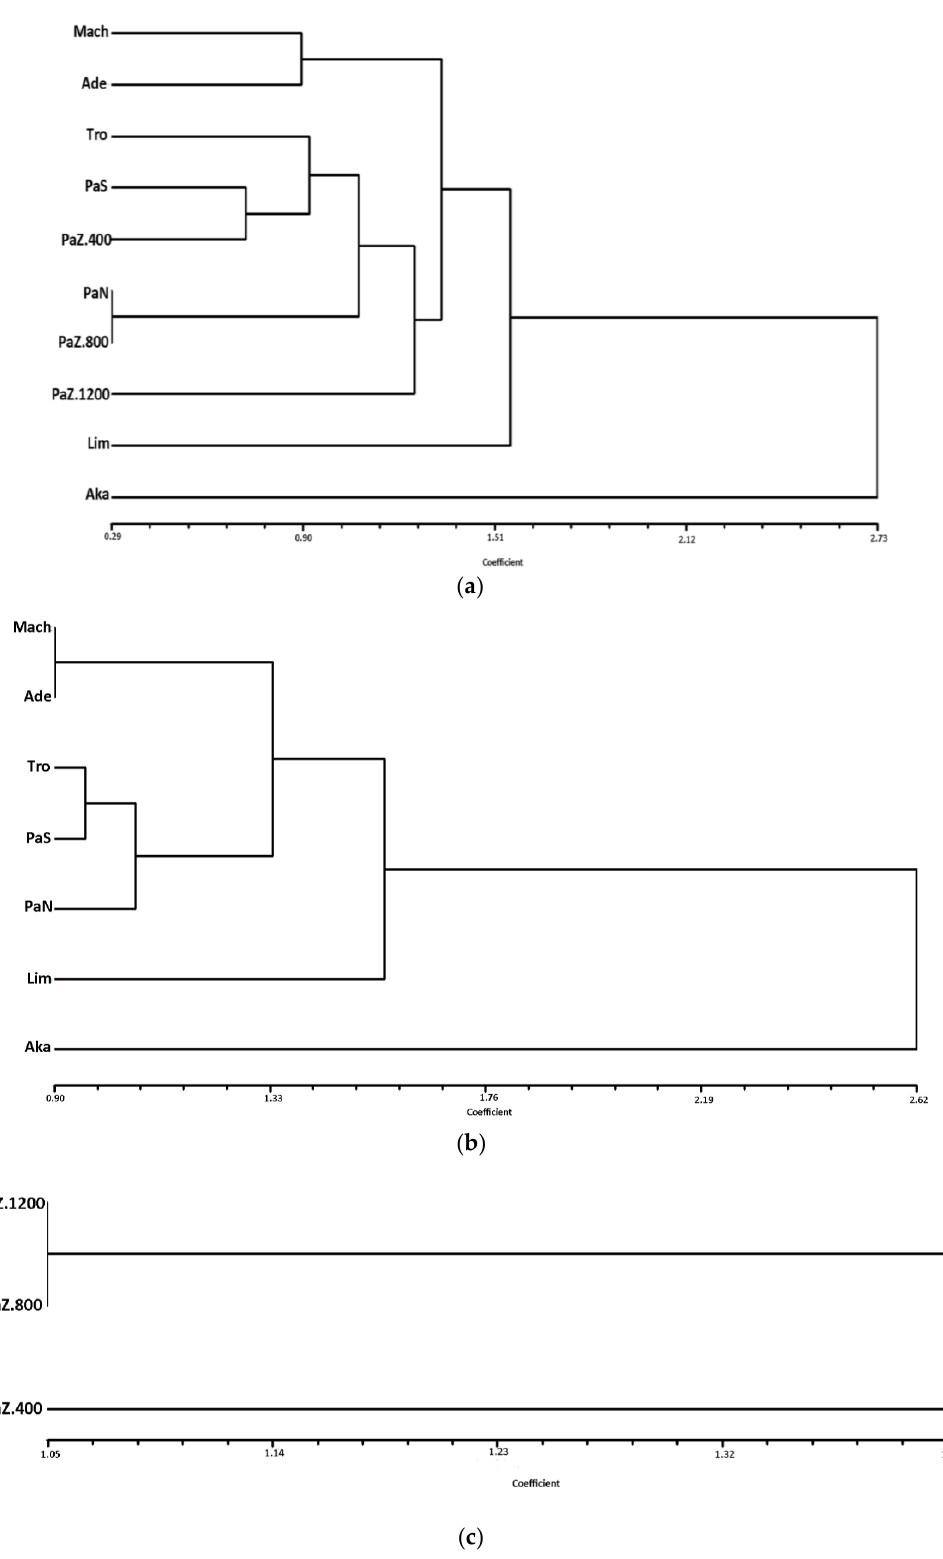
Figure 5. Unweighted pair group method wit arithmetic average (UPGMA) dendrogram based on Euclidean distances for morphoanatomical traits. ( a ) All sampled subpopulations; ( b ) wide-range subpopulation level; ( c ) altitudinal